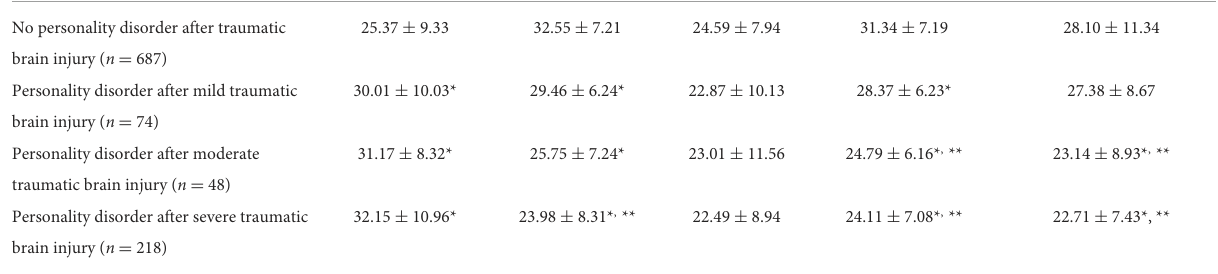
TABLE 4 The scores in five dimensions of personality disorder.